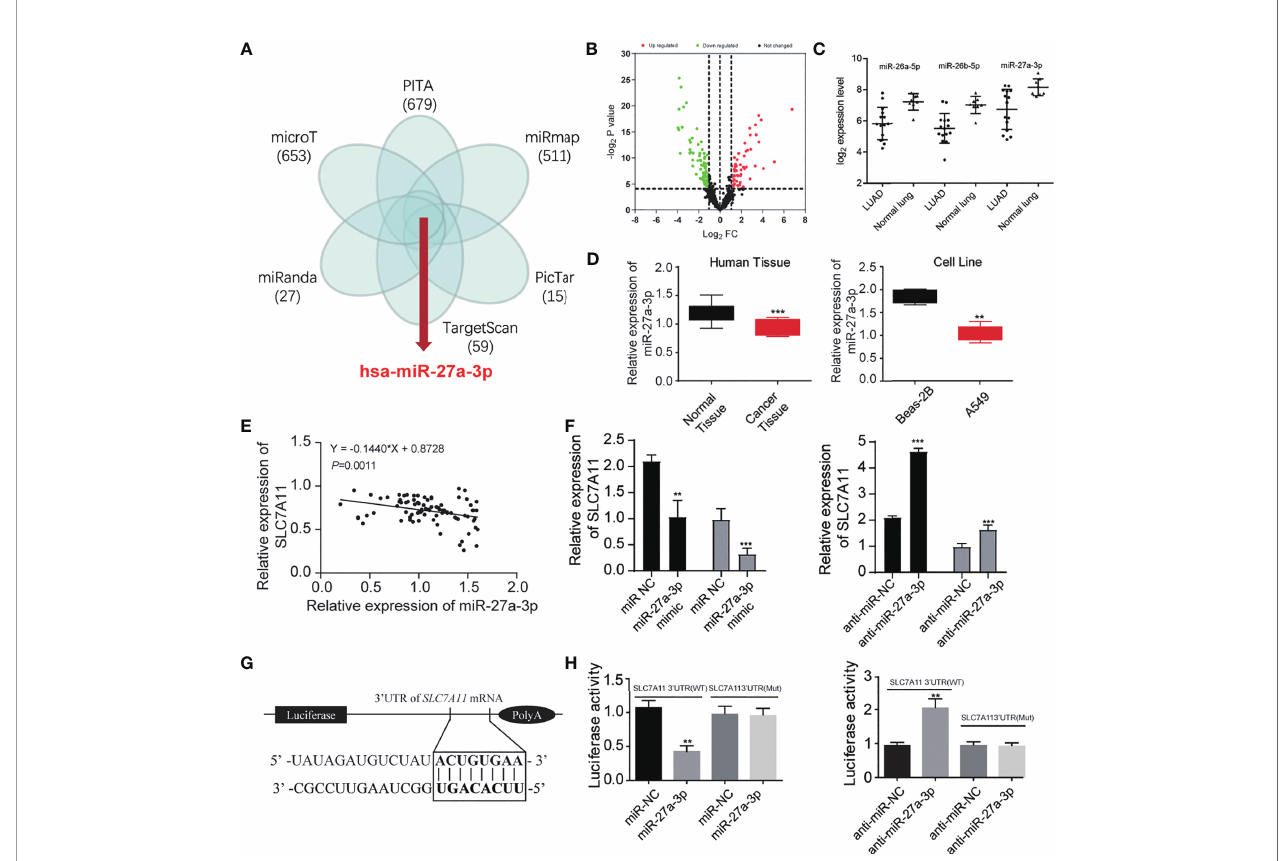
FIGURE 4 | miR-27a-3p is the regulator of SLC7A11 protein. (A) Predicted the miRNAs targeting SLC7A11 using TargetSan, miRanda, microT, PITA, miRmap, and PicTar databases. (B) Volcano plot indicating the downregulated and upregulated microRNA in NSCLC tissues. (C) Three overlapping miRNAs were screened out including miR-26a-5p, miR-26b-5p, and miR-27a-3p. (D) Measurement of miR-27a-3p expression in the tissues and cell lines of NSCLC. (E) The correlation of SLC7A11 with miR-27a-3p. (F) Determination of the SLC7A11 expression level in miR-27a-3p mimic and anti-miR-27a-3p treated A549 cells, respectively. (G) Prediction of miR-27a-3p ’ s e binding sites in SLC7A11. (H) Detection of luciferase activity of A549 cells with cotransfection of SLC7A11 (WT) or SLC7A11 (MUT) and miR-27a-3p or anti-miR-27a-3p. **P < 0.01 and ***P < 0.001